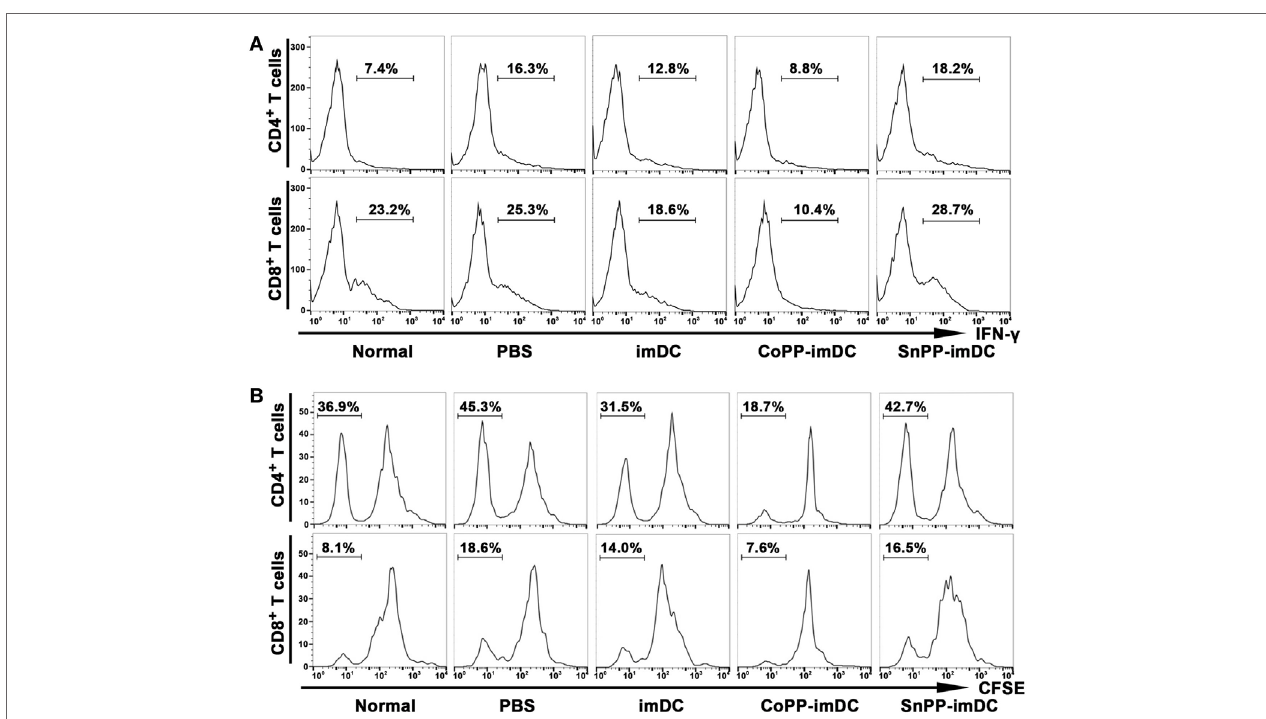
FigUre 7 | Adoptive transfer of donor-derived HO-1 hi immature dendritic cells (imDCs) is more efficient in suppressing the activation and proliferation of recipient lymphocytes. Untreated, cobalt protoporphyrin-pretreated, or SnPP-pretreated donor-derived imDCs (5 × 10 6 ) were injected intravenously into recipient mice, and heart transplantation was performed 7 days later. As a control, recipient mice received no cell transfusion, and only an injection of the same volume of PBS. The splenocytes were isolated from normal C57BL/6 mouse spleens or recipient spleens collected 7 days after heart transplantation ( n = 3 per group). (a) The expression of IFN- γ in CD4 + or CD8 + T cells was detected by flow cytometry. Representative FACS results of three independent experiments are shown. (B) mixed leukocyte reaction (MLR) was performed using irradiated donor splenocytes as stimulator cells and CFSE-labeled recipient splenocytes as responder cells. The proliferation of recipient CD4 + and CD8 + T cells was measured by FACS after a 7-day MLR. Representative FACS results of three independent experiments are